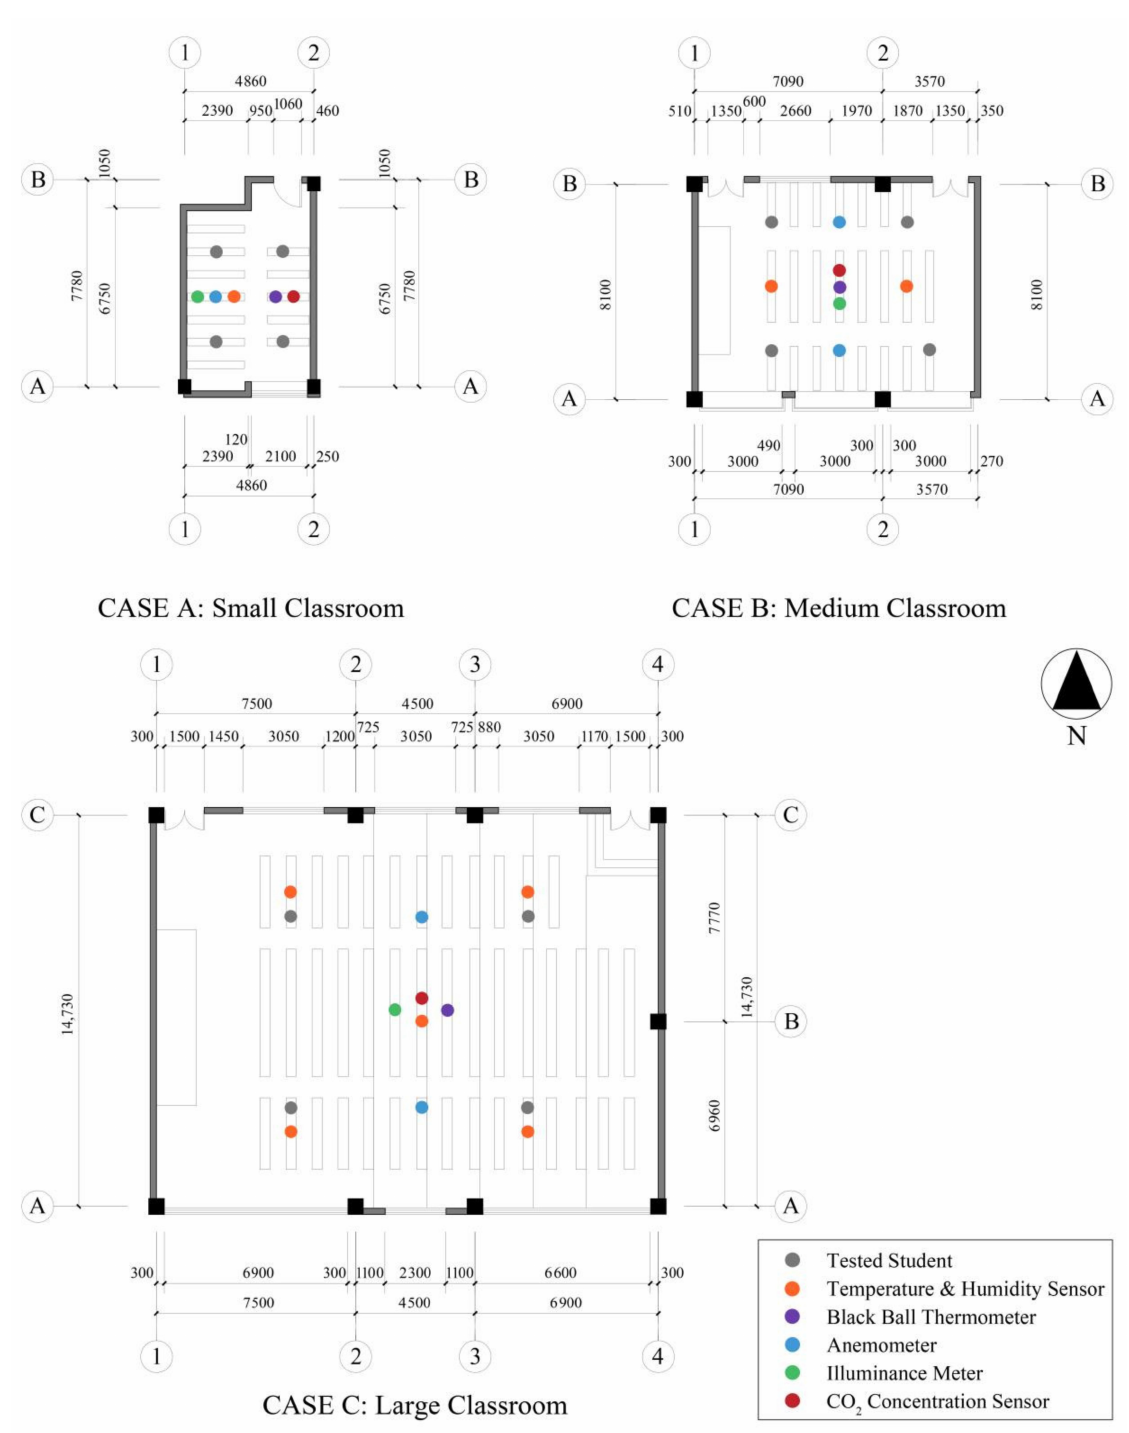
Figure 6. Layout of the case A, B, and